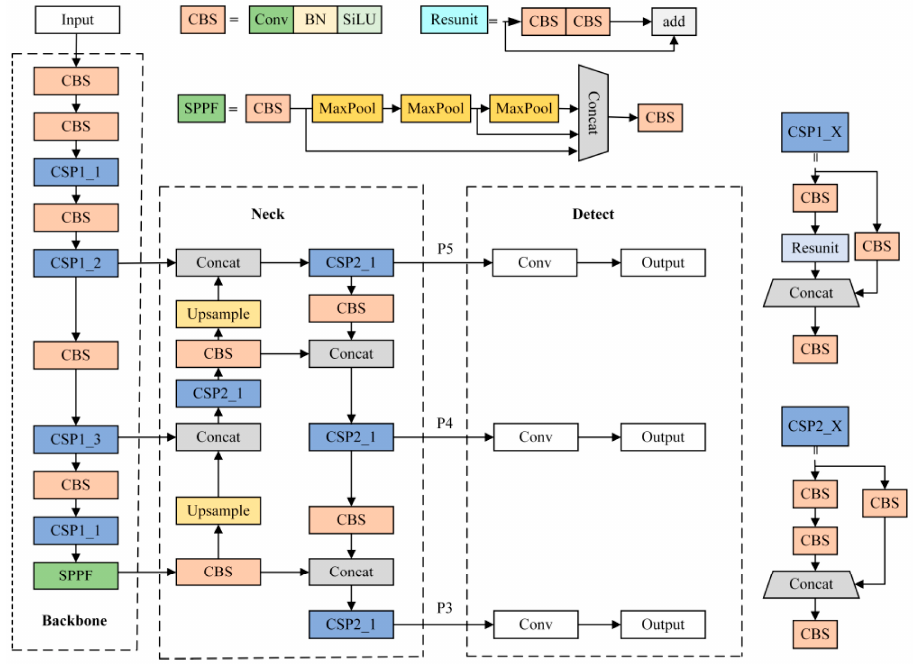
Figure 1. The structure of YOLOv5 network.